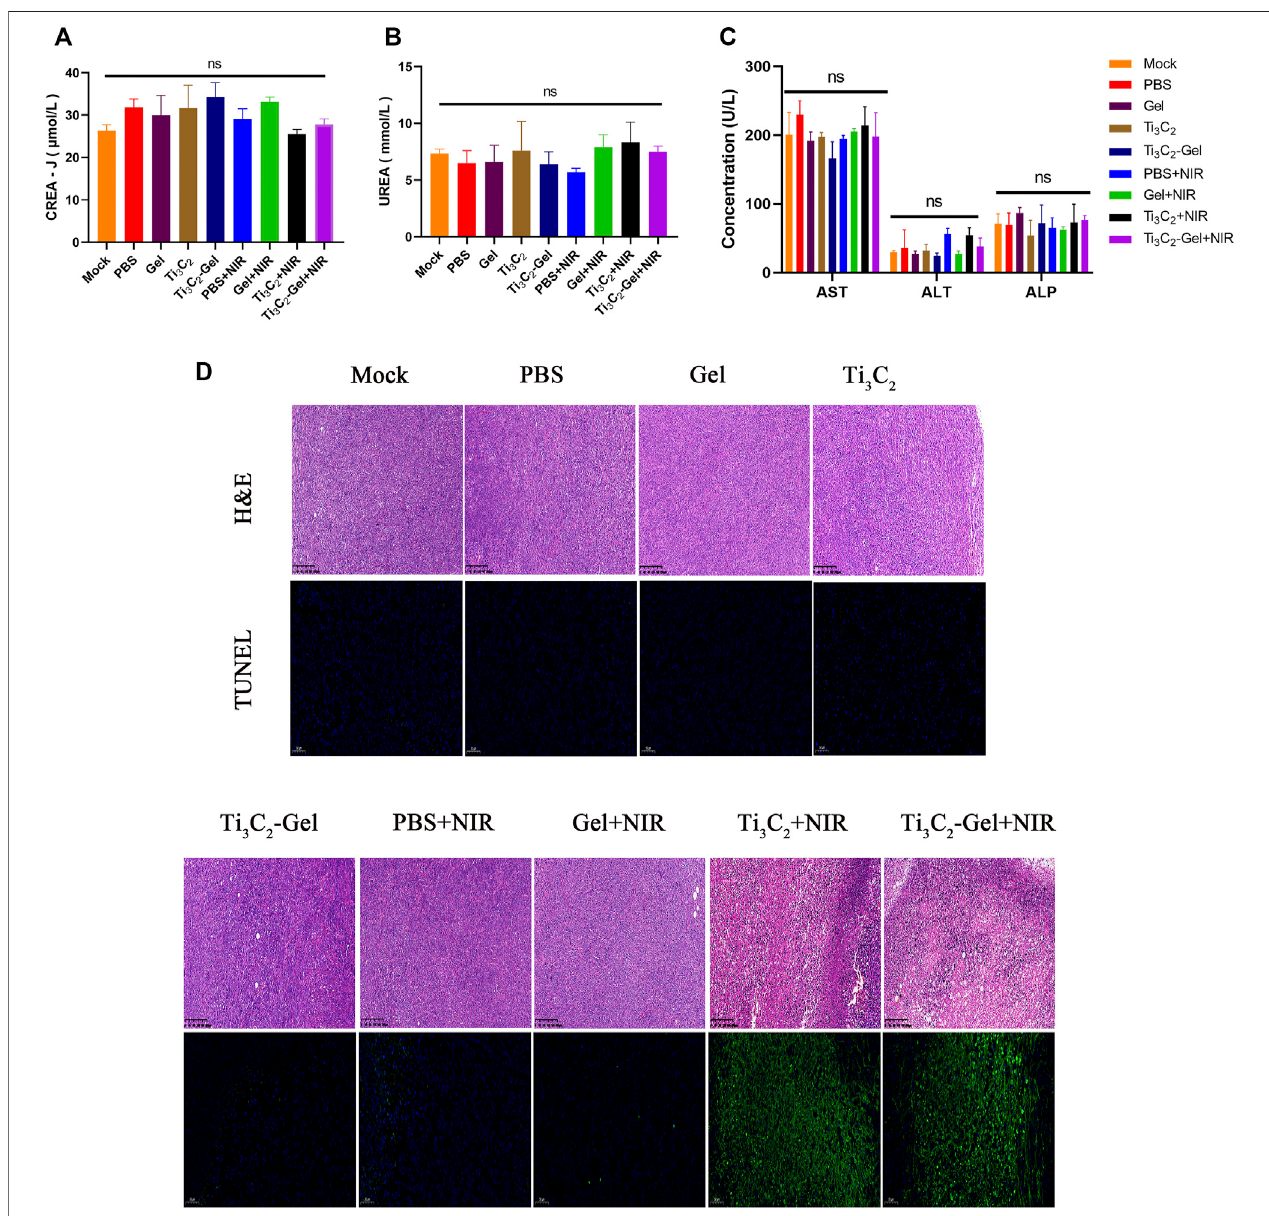
FIGURE 6 | In vivo safety evaluation. (A – C) Blood biochemistry analysis (including indicators of liver and kidney function) of mice after various treatments. n (cid:2) 3/ group, mean ± SD. (D) Hematoxylin and eosin staining and TUNEL staining of tumor sections from different treatment groups.